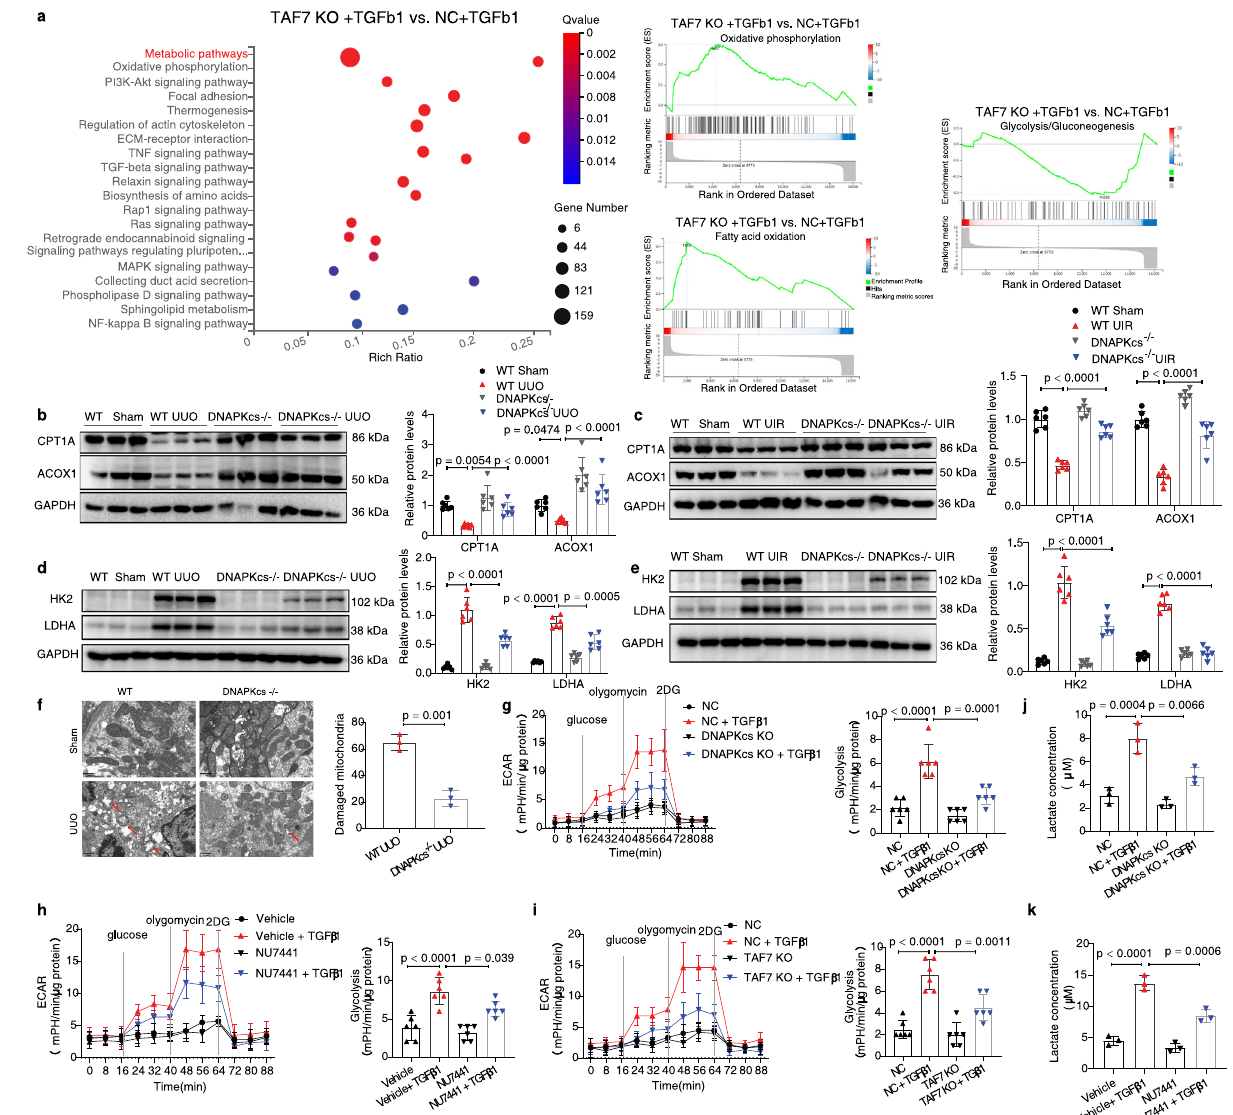
Fig. 7 | Inhibition of DNA-PK or TAF7 corrects metabolic reprogramming. a RNA-seq showing that metabolic signaling (indicated by red font) was the top differentially expressed signaling pathway between TAF7 − / − +TGF β 1 and NC+ TGF β 1. GSEA revealed signi fi cant upregulation of oxidative phosphorylation and FAObutinhibitionofglycolysisinTGF β 1-treatedTAF7knockoutmPTCscompared to NC controls, n =2 for each group. b Protein levels of ACOX1 and CPT1 α were analyzed in kidney tissues of DNA-PKcs − / − and WT control mice subjected to UUO (day 7) or UIR (day 21) ( c ). Bars represent quanti fi cation results (mean±SD, n =6 mice of each group). d Protein levels of LDHA and HK2 were analyzed in kidney tissues of DNA-PKcs − / − and WT control mice subjected to UUO (day 7) or UIR (day 21) ( e ).Barsrepresent quanti fi cation results (mean±SD, n =6 miceofeach group). f ElectronmicroscopyshowingthatUUO(day7)-inducedmitochondrialdamagein proximal tubule cells of WT mice was almost eliminated by DNA-PKcs knockout, scalebars:1 μ m.Barsrepresentquanti fi cationresults(mean±SD, n =3miceofeach